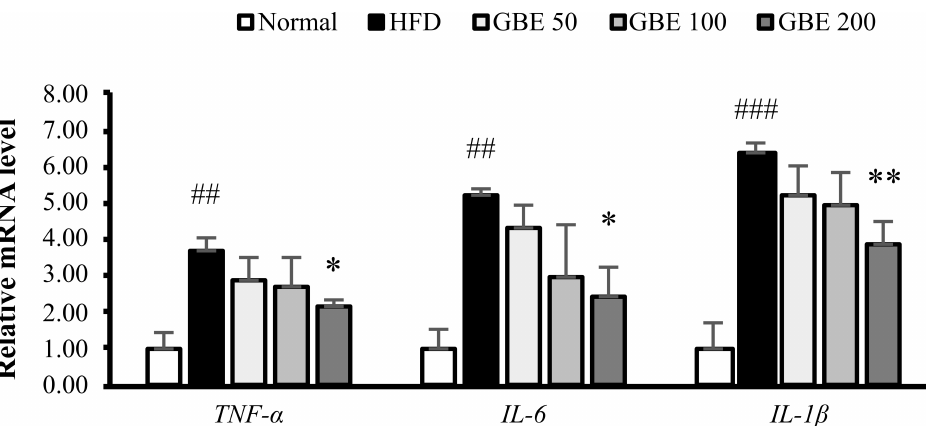
(cid:0)(cid:2)(cid:3)(cid:4)(cid:2)(cid:3)(cid:3)(cid:5)(cid:6)(cid:3)(cid:7)(cid:0)(cid:3)(cid:6)(cid:8)(cid:9)